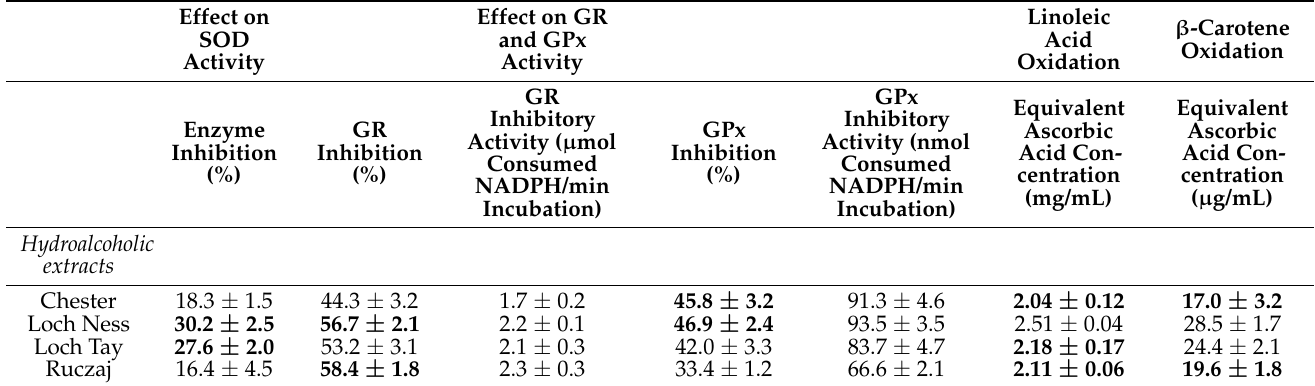
Table 4. Antioxidant activity of blackberry leaves hydroalcoholic extracts.